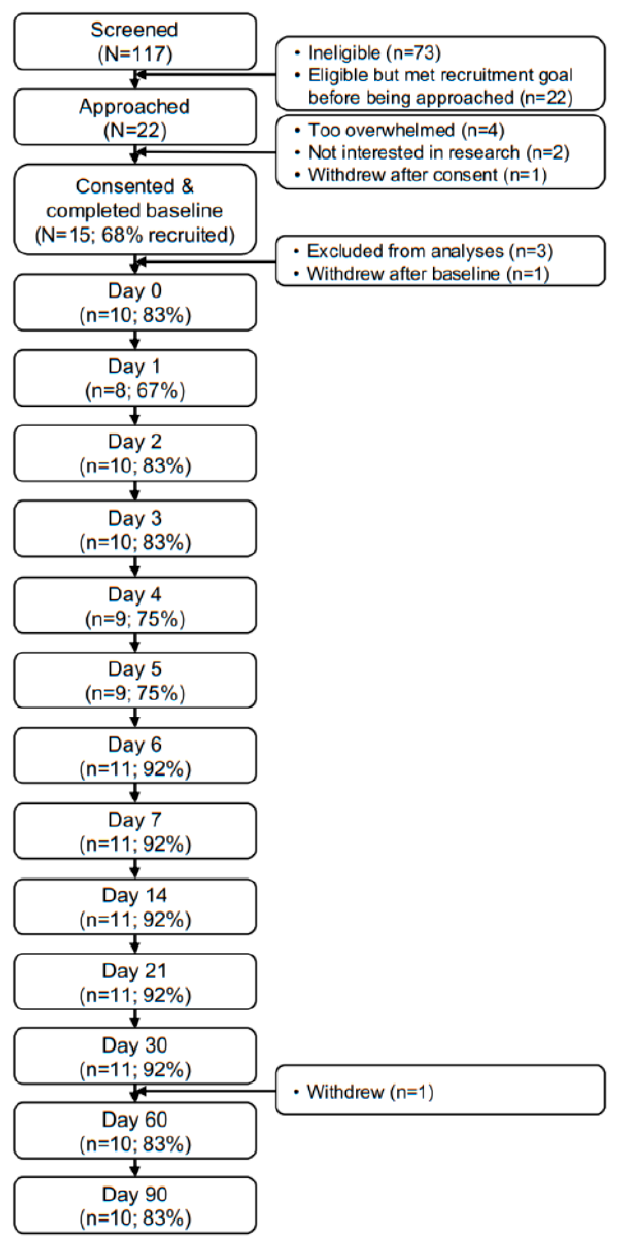
Figure 1. Participant flow diagram.